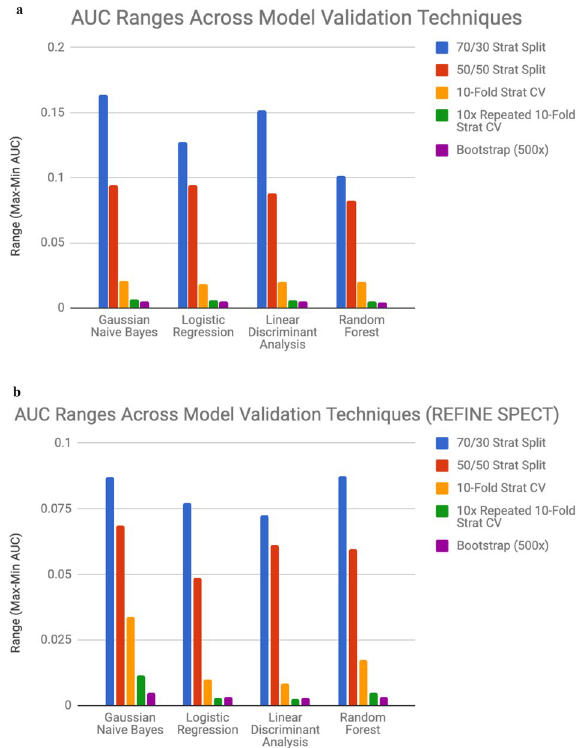
Figure 1. The maximum and minimum AUCs were calculated (over the 100 iterations) for each algorithm corresponding to the various model validation techniques. Their difference (range) plotted on the y-axis represents the maximum variation observed from the iterations attributed to seed alterations for the model. AUC area under the ROC curve. ROC receiver operating characteristic curve. CV cross-validation.